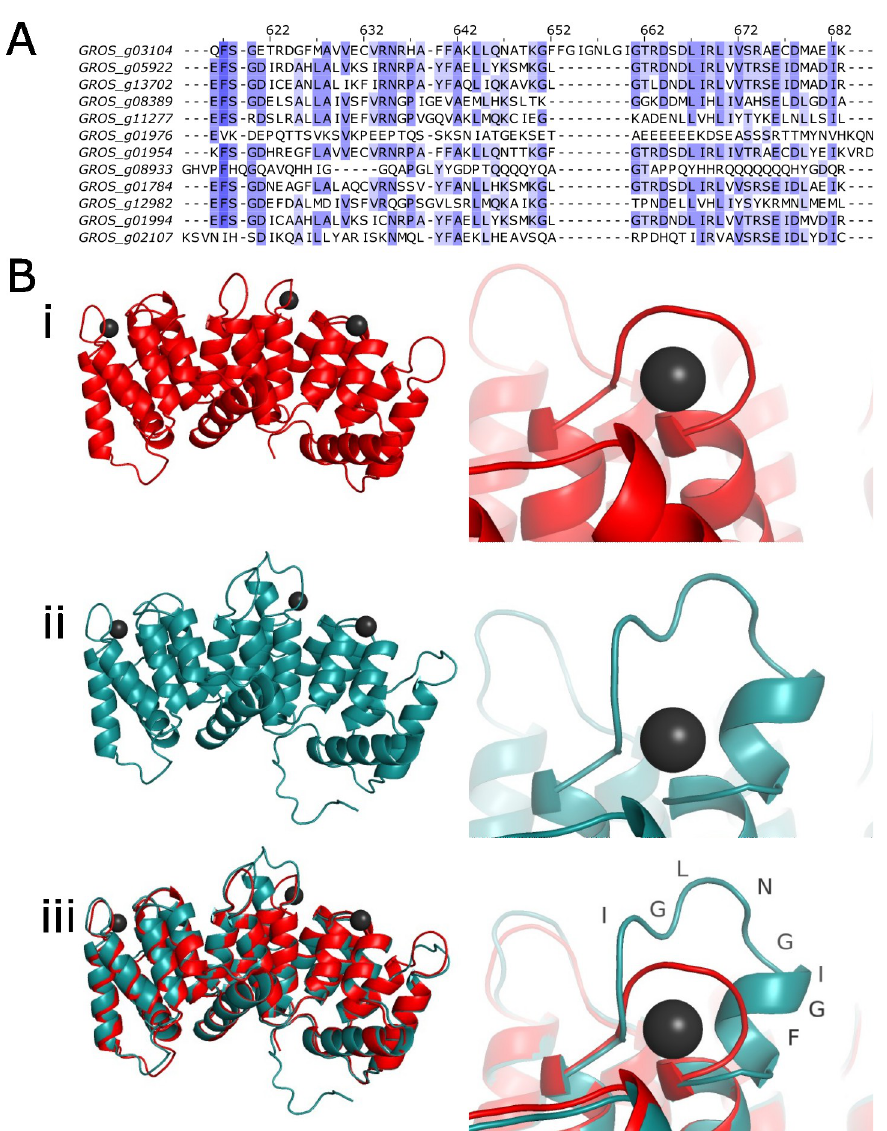
Fig 1. Annexin sequence and structure. (A) Alignment of G . rostochiensis annexin sequences. The annexin identified in mass spectrometry data (GROS_g03104) is distinguished by the unique peptide N- 267 FFGIGNLGI 275 -C. Blue colouring indicates conserved amino acids between proteins. (B) Structural prediction for GROS_g03104 from phyre2. (i), Crystal structure of bovine annexin VI PDB ID: 1AVC with black spheres representing calcium ions bound to 1AVC annexin structure. (ii), predicted structure for GROS_g03104 with focus on Globodera spp . unique insertion and overlay of calcium ions associated with bovine annexin 1AVC. (iii), overlay of PDB ID: 1AVC and the GROS_g03104